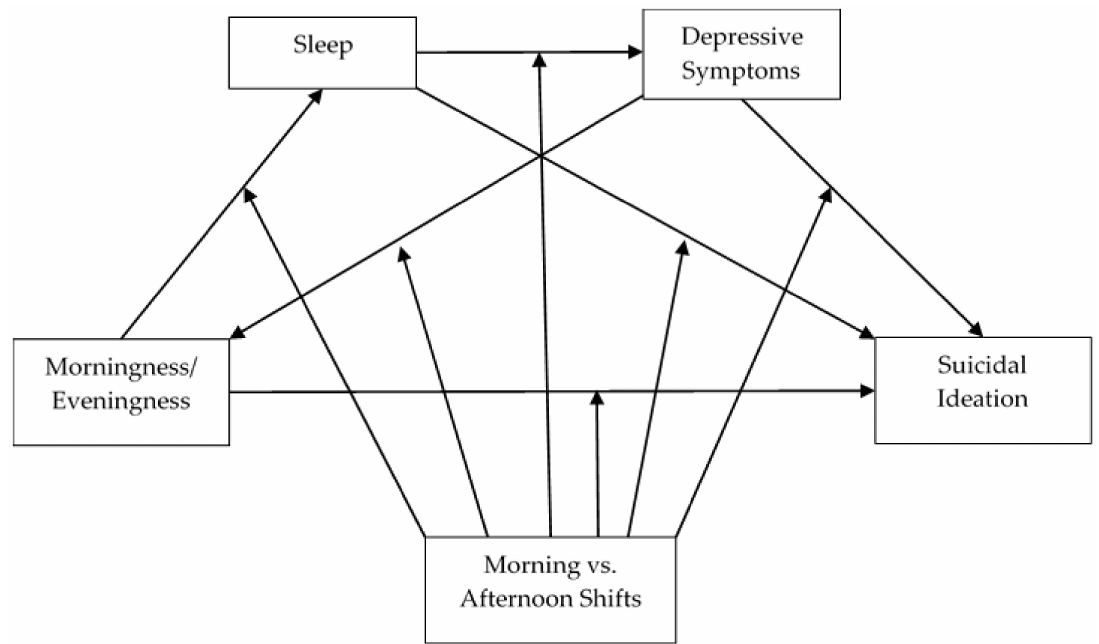
Figure 1. Moderated-Mediated Model to test the morningness/eveningness effect on suicidal ideation through sleep and depressive symptom mediators, with school shift as the